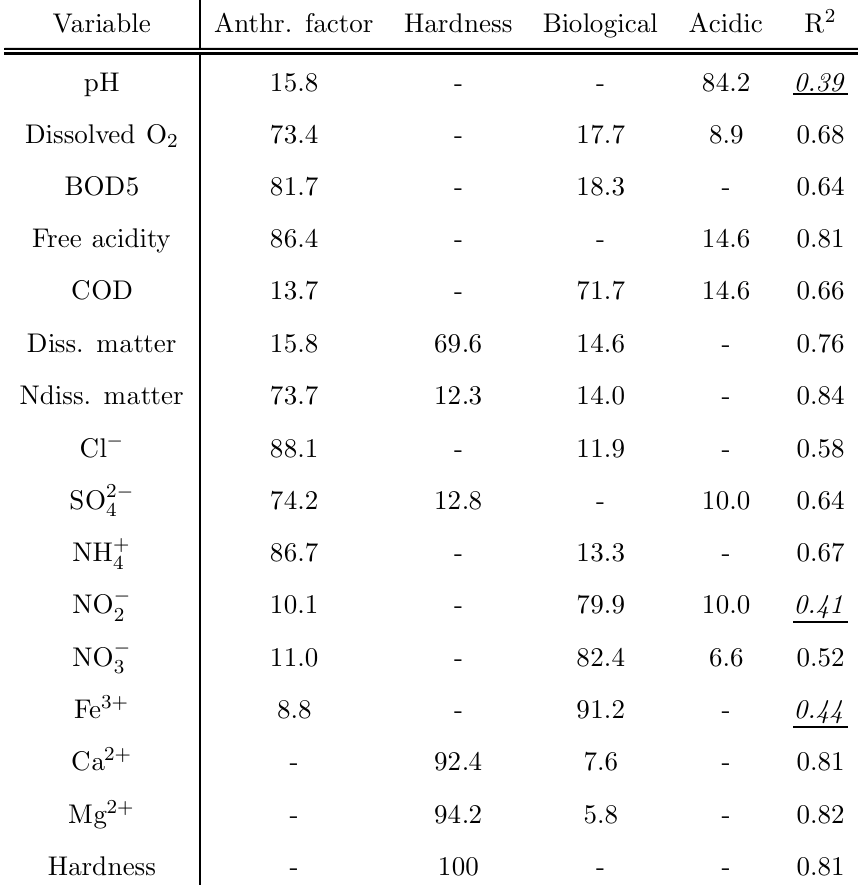
Table 4 Source apportioning results (in %